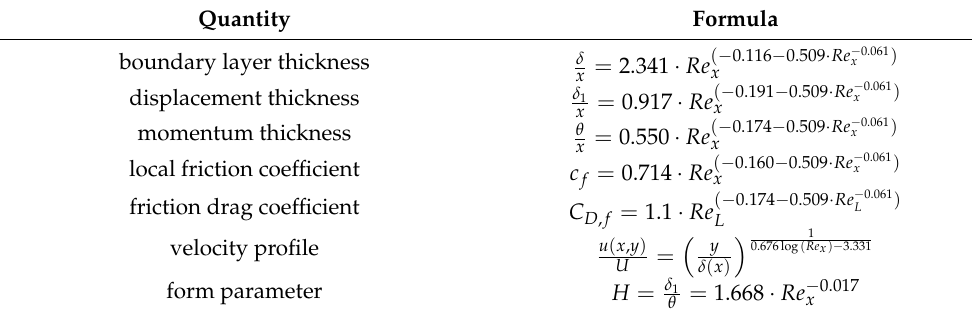
Table 1. Boundary layer